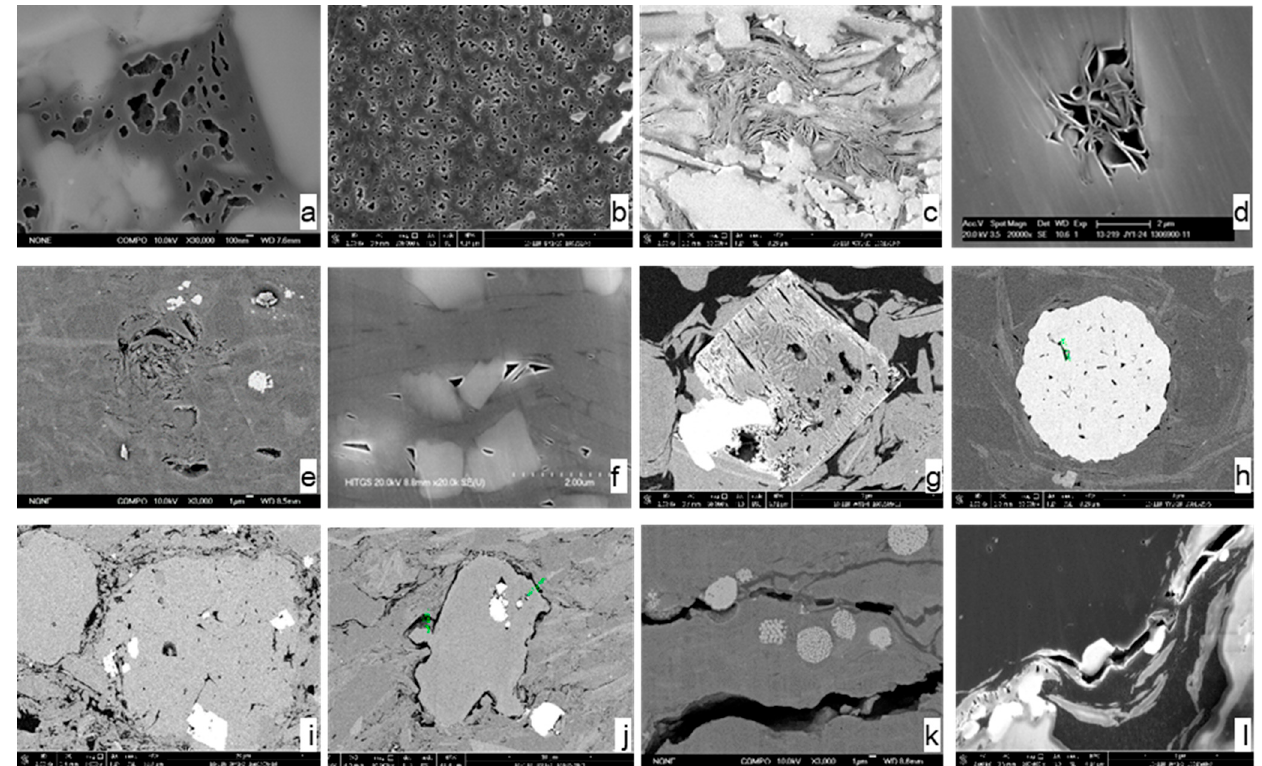
Figure 8. Scanning electron microscope (SEM) photographs of pores in reservoir of Wufeng-Longmaxi Formation in Sichuan Basin. ( a , b ): organic pores; ( c , d ): interbedded pores of clay minerals; ( e , f ): intergranular pores; ( g ): intragranular pores of feldspar dissolution; ( h ): intragranular pores among pyrite crystals; ( i ): intragranular pores of quartz dissolution; ( j ): microfractures around rigid particles; ( k , l ): microfractures in organic matter.